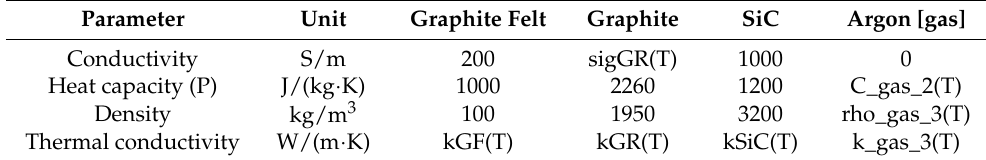
Table 2. Physical Parameters of Main